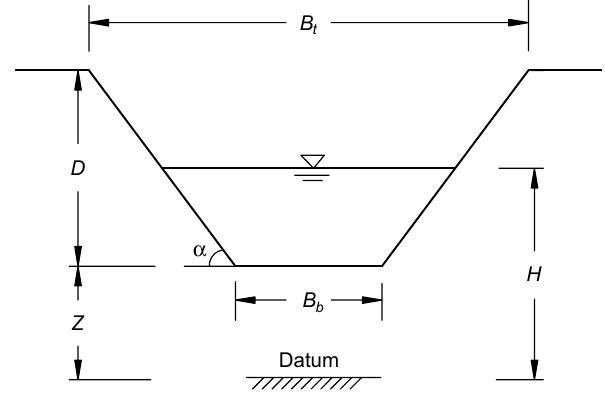
Fig. 3. Geometry of a typical breach cross-section.